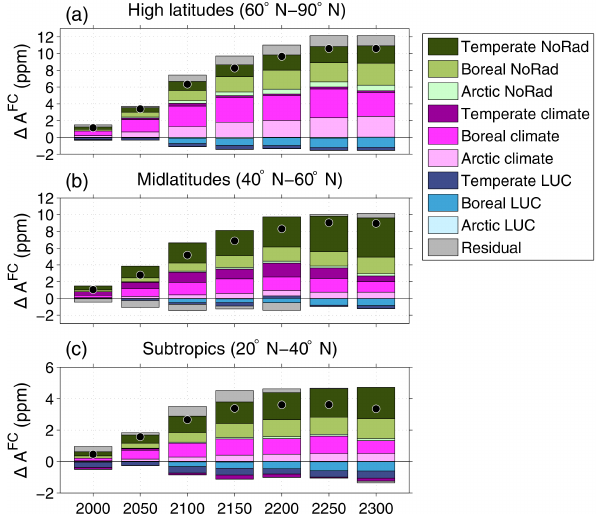
Figure 13. Contributions of temperate, boreal, and Arctic combined CO 2 fertilization and N deposition (NoRad), climate change (Cli- mate), land use change (LUC) to the change in the FullyCoupled mean atmospheric CO 2 annual cycle amplitude from 1950–1959 values ( (cid:49)A FC , black circles) in the decades ending in 2000, 2050, 2100, 2150, 2200, 2250, and 2300 over (a) the NH high latitudes, (b) the NH midlatitudes, and (c) the NH subtropics. Residual val- ues are the sums of the contributions of LUC, climate change, CO 2 fertilization, and N deposition in the subtropical, tropical, and SH GEOS-Chem land regions. Negative values indicate that the forcing decreased the atmospheric CO 2 annual cycle amplitude. Units are ppm.